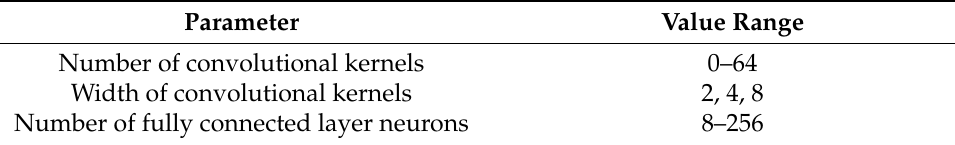
Table 4. Parameter search range based on 2D-CNN and TCN